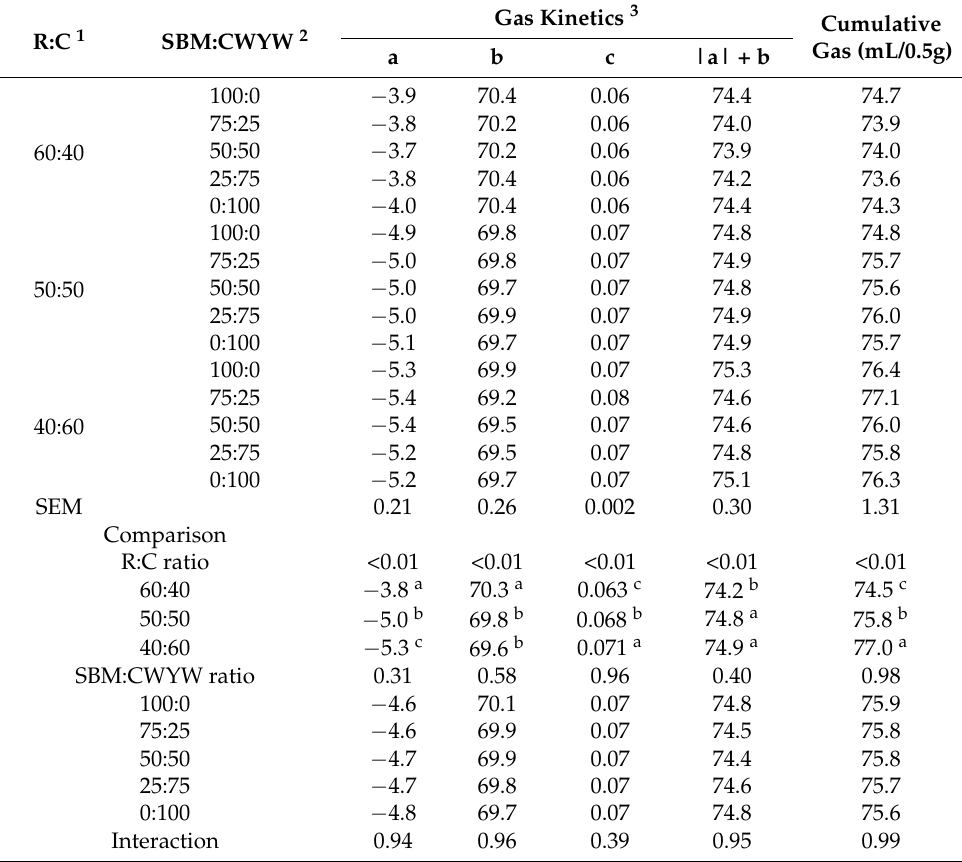
Table 2. Effect of R:C ratio level combined with SBM:CWYW ratio level on gas kinetics and cumula- tive gas at 96 h after